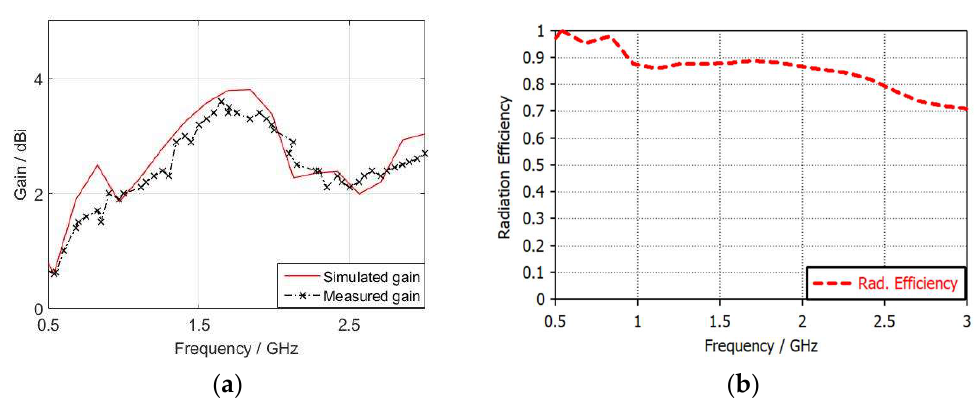
Figure 14. ( a ) Gain in dBi vs. frequency, ( b ) radiation efficiency vs. frequency.